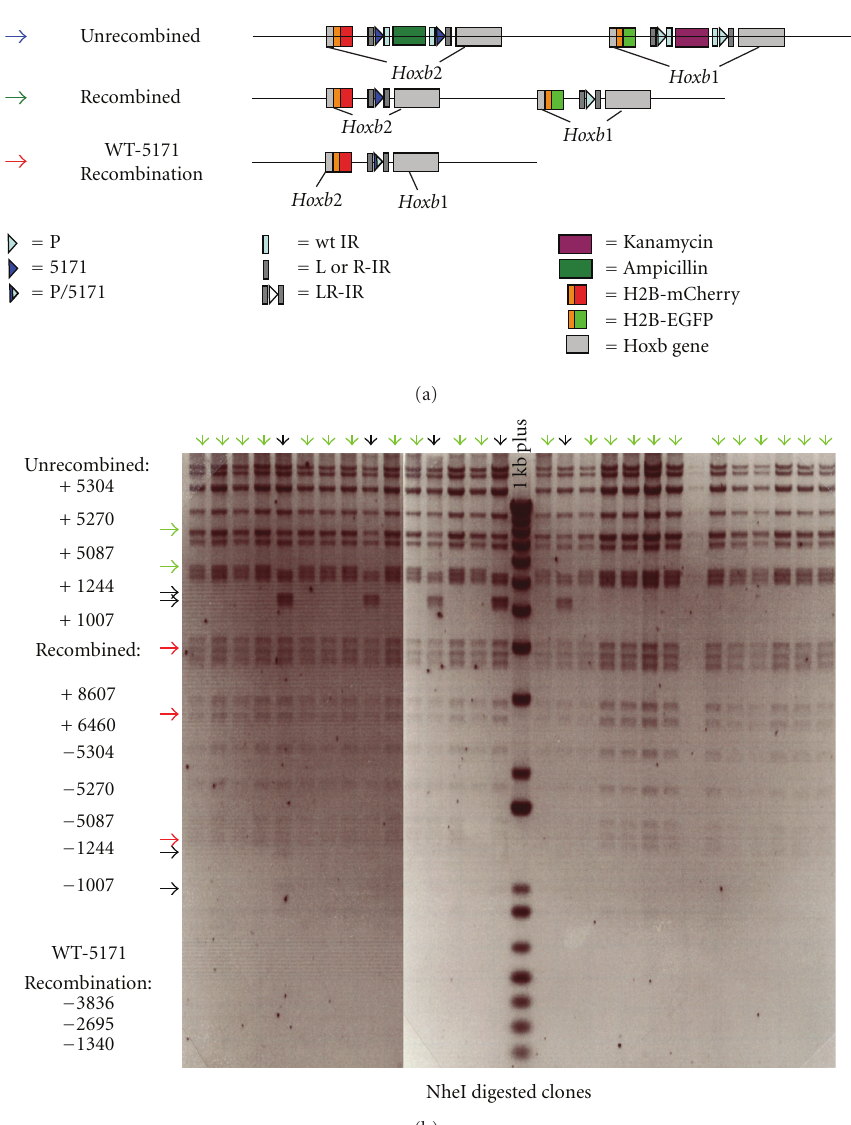
Figure 6: Analyses of simultaneous deletions. (a) The BAC construct with targeted insertions in Hoxb1 and Hoxb2 used as a substrate for assaying Cre-mediated recombination (top). This construct contains one LoxP-flanked Kanamycin cassette and one Lox5171-flanked Ampicillin cassette. Successful recombination (middle) will eliminate the Kanamycin and Ampicillin resistance cassettes and leave a LR- LoxP and LR-Lox5171 recombination resistant site at the respective locations. Recombination between mismatched sites (LoxP × Lox5171) (bottom) will result in the deletion of both cassettes and leave a single hybrid Lox site between segments of the Hoxb2 and Hoxb1 genes. The symbols for each of the components in the diagrams are noted below. (b) NheI digest of clones resulting from Cre-mediated recombination of the BAC substrate. Green arrows indicate features of a successful/specific multiple recombination. Black arrows mark features of BACs that have failed to recombine and Red arrows show features that indicate fragments that should be absent in the case of (LoxP) × (Lox5171) mistargeted recombination. Fragment list on left displays alterations to the reactant BAC NheI banding pattern that would occur in each of the three possible